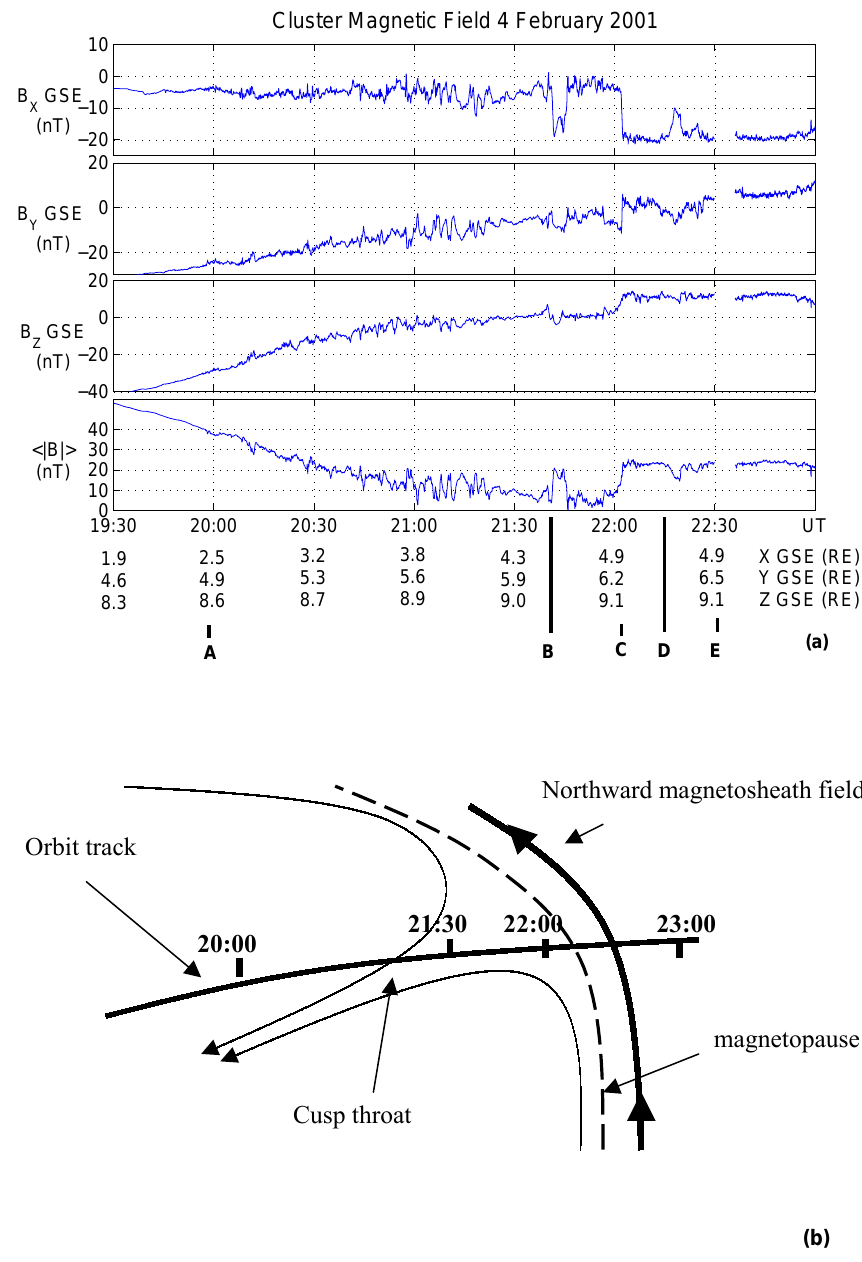
Fig. 10. (a) Magnetic field data from the FGM sensor on Cluster 3 (Samba). Notation is the same for Fig. 9. We note the change after 21:40, marked B, corresponding to an energetic electron event and the initial entry into the magnetosheath just after 22:00, as inferred from the electron data in Fig. 9. Using this magnetic field data along with the orbit position and MLT data, we propose the orbit path sketched in (b) , with the orbit passing directly through the throat of the cusp, with the energetic electron event occurring within this